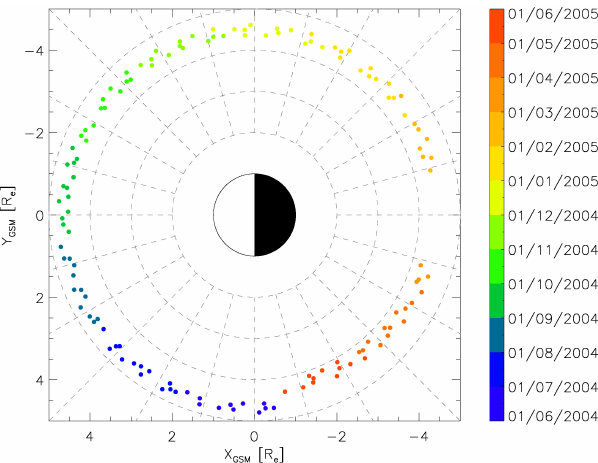
Fig. 10. The MLT position of the perigee and the minimum geo- centric distance of all the Cluster passes analysed in this study. The colour of each datum gives the month according to the colour bar on the